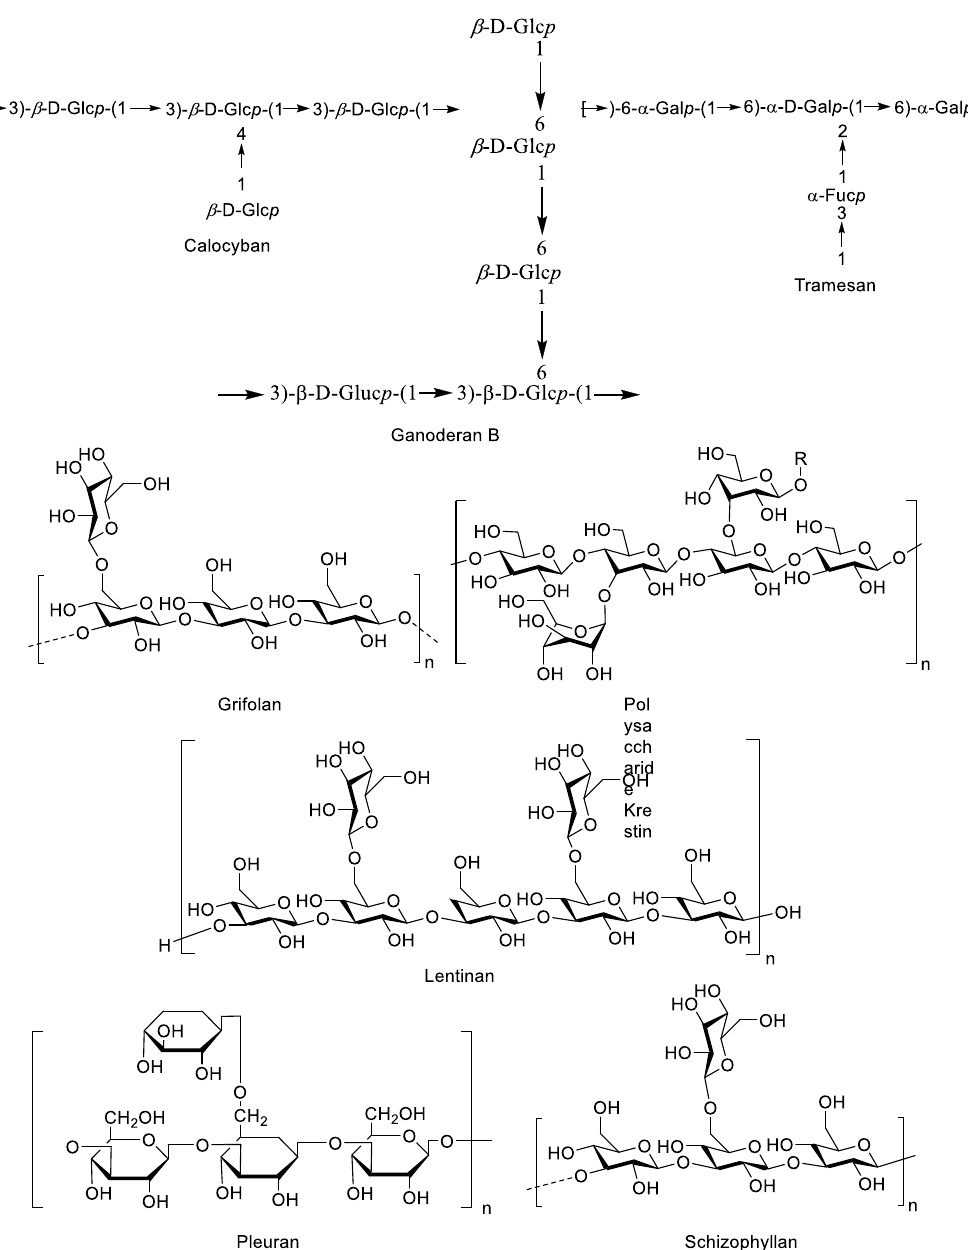
Figure 1. Chemical structures of 𝛽 -glucans isolated from some economically important macrofungi.